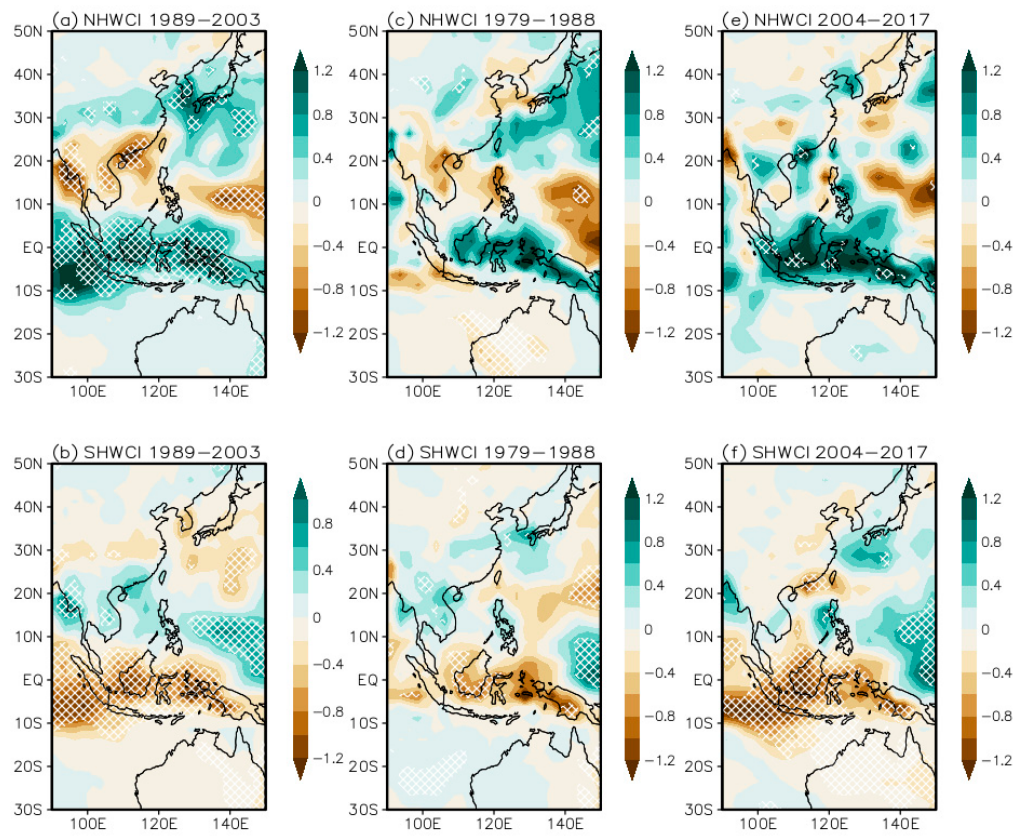
Figure 13. Linear regression maps of the NHMCI and SHMCI with the summer precipitation field during ( a , b ) 1989–2004; ( c , d ) 1979–1988; and ( e , f ) 2004–2017 (unit mm / day). The gridded regions represent the correlations that are positively and negatively significant at the 95% confidence level.